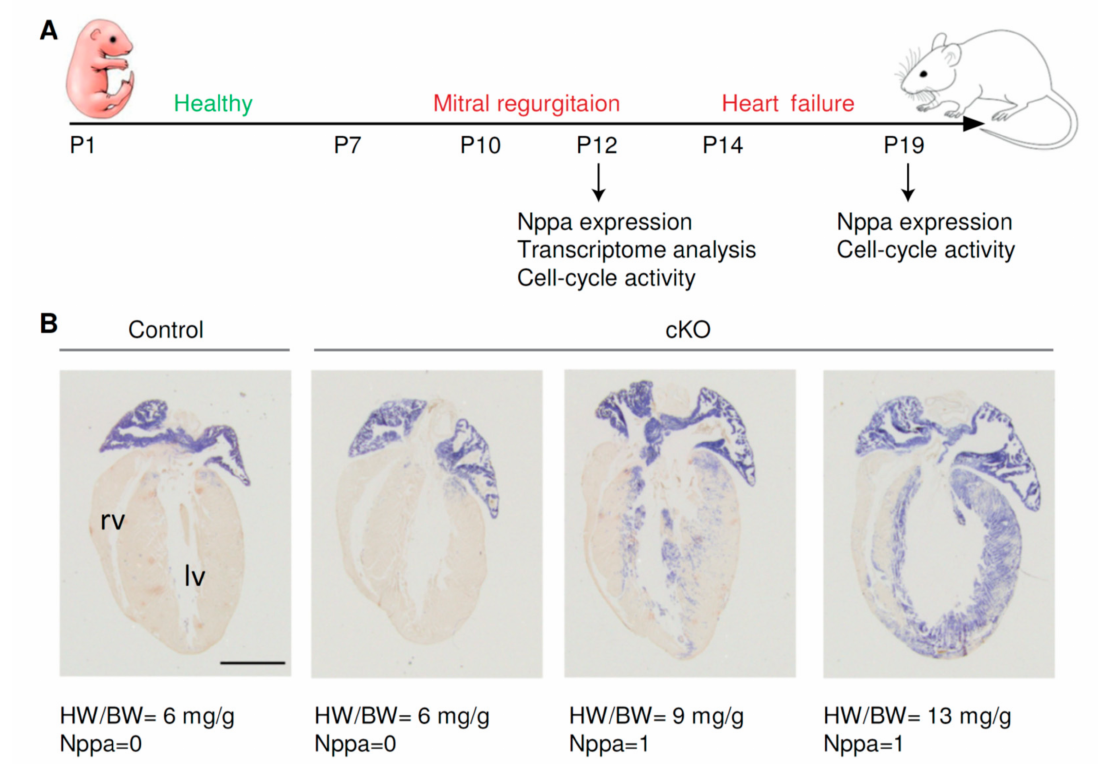
Figure 2. ( A ) Schematic overview of the performed experiments. Starting from postnatal day (P) 10, cKO mice develop mitral regurgitation and heart failure. The transcriptome and Nppa expression of cardiomyocytes were analyzed at P12. Cardiomyocyte cell-cycle activity was studied by staining with anti-Ki-67 at P12 and P19. ( B ) In situ hybridization shows the expression of Nppa in control and cKO hearts at P12. Mice that express Nppa in the left ventricle have higher heart-weight- to-body-weight ratios (HW/BW). According to the expression pattern of Nppa , hearts received a Nppa score of 0 ( Nppa not expressed in the left ventricle or only expressed at the base of the in the left ventricle) and Nppa = 1 ( Nppa expression in the left ventricle and luminal side of the interventricular septum). Scale bar indicates 1 mm. lv. Left ventricle; rv, right